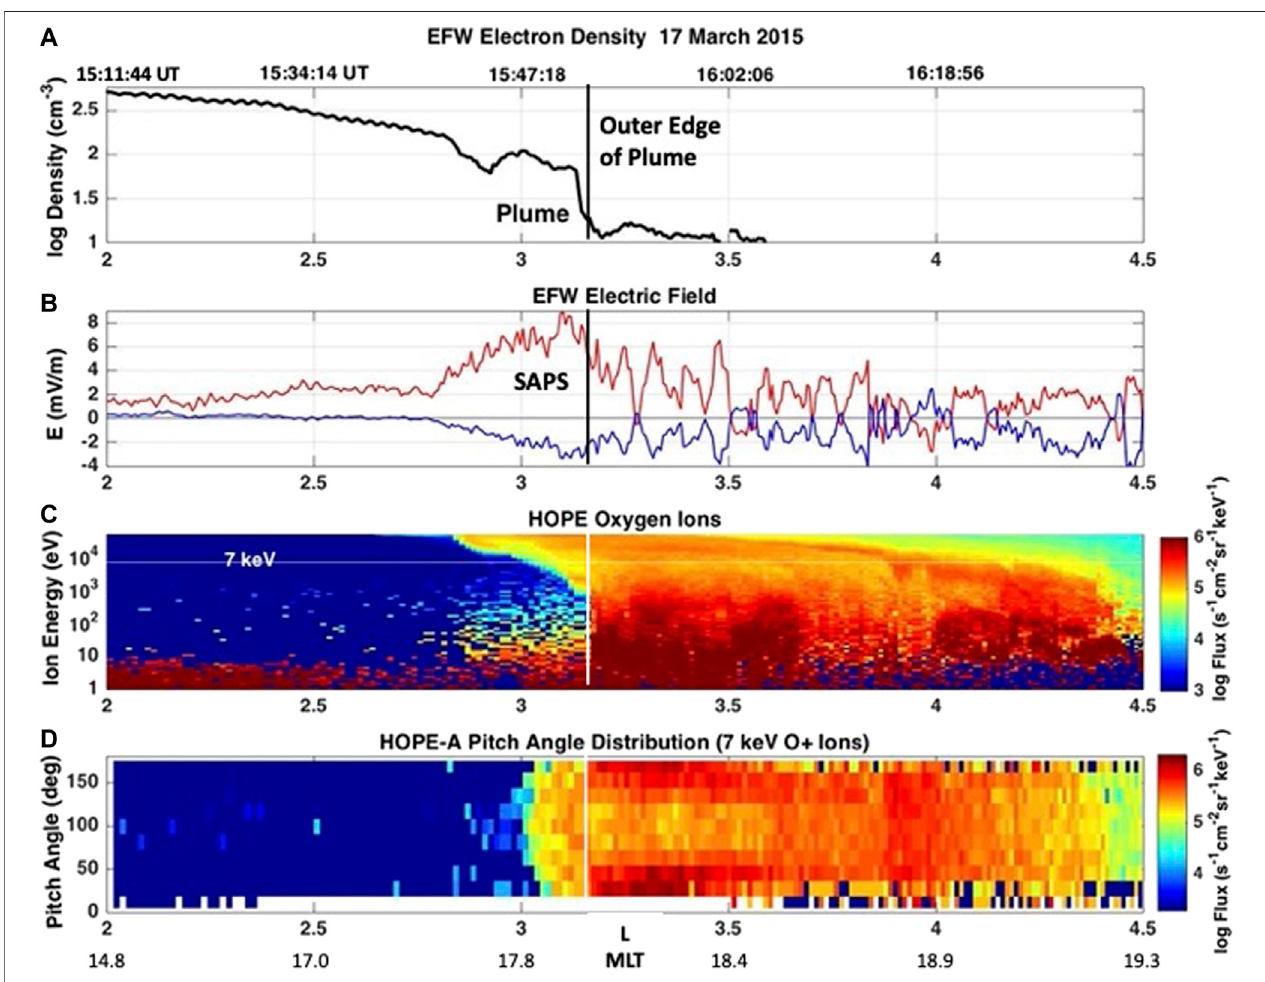
FIGURE 1 | Van Allen Probes A observations crossing the disturbed plasmasphere boundary layer. (A) In situ cold plasma density observations (EFW boom potential technique). (B) Red curve: radially outward EFW electric fi eld (blue curve: azimuthal component). (C) HOPE O+ fl uxes (10 eV — ∼ 60 keV) are shown. O+ with energies < 3 keV largely is excluded from plume fi eld lines. A “ nose ” of hot ring current O + ions ( > 10 keV) extended across the SAPS. (D) Bi-directional fi eld aligned O+ fl uxes at energies up to ∼ 10 keV (7 keV fl uxes shown) were seen immediately adjacent to the outer extent of the geospace plume. [After Foster et al. (2020)].